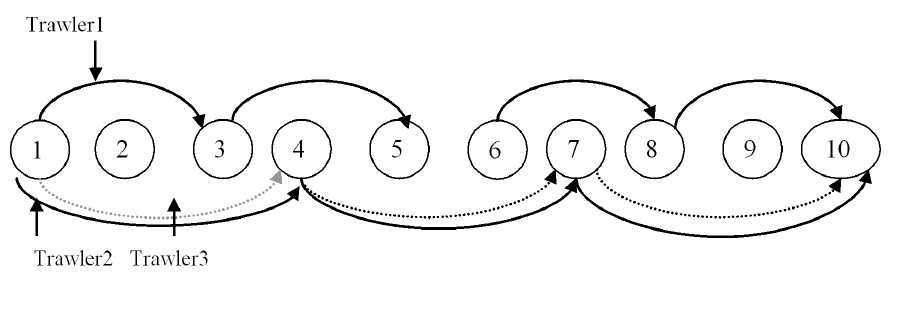
Figure 3: A sample fishing trawler scheduling for a 10-period